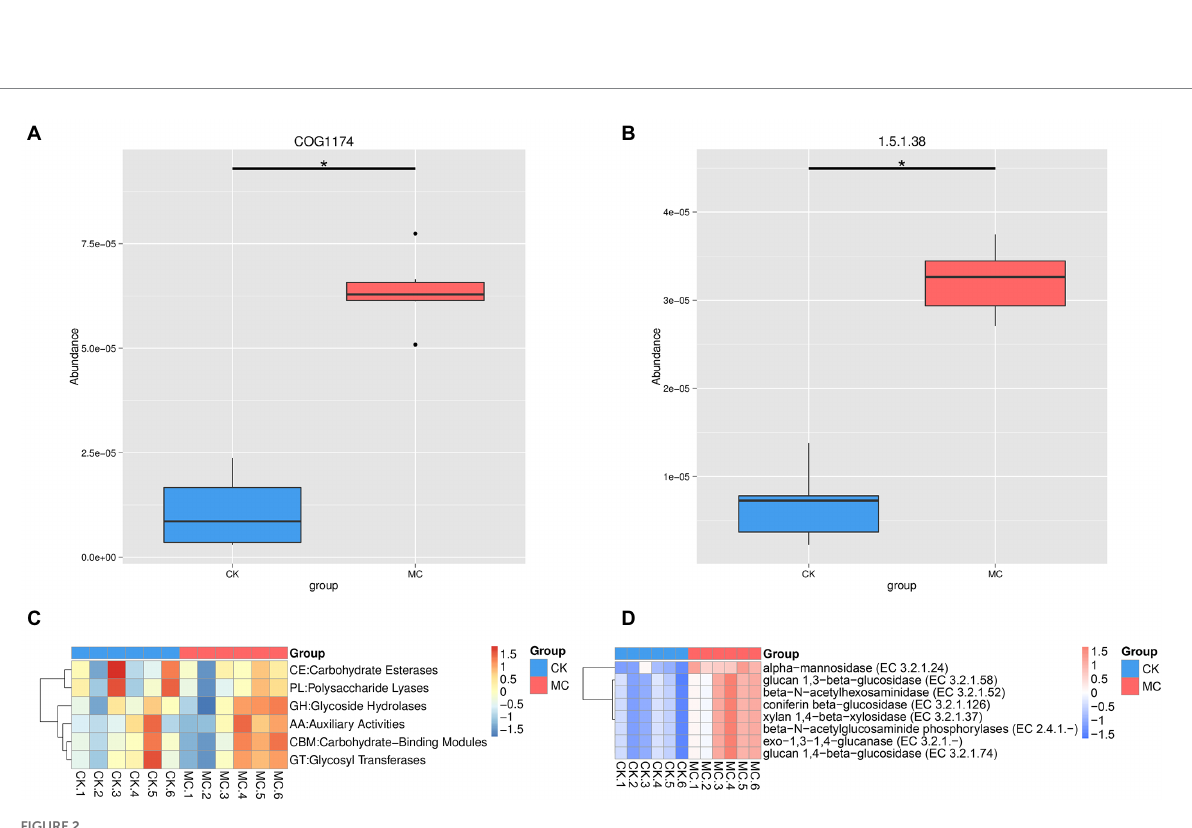
FIGURE 2 Significantly altered gene function of intestinal microbial of L. vannamei after MC-LR exposure. (A) eggNOG function. (B) KEGG function. (C) CAZy categories. (D) CAZy species. * represents significant difference between the CK and MC groups ( q <